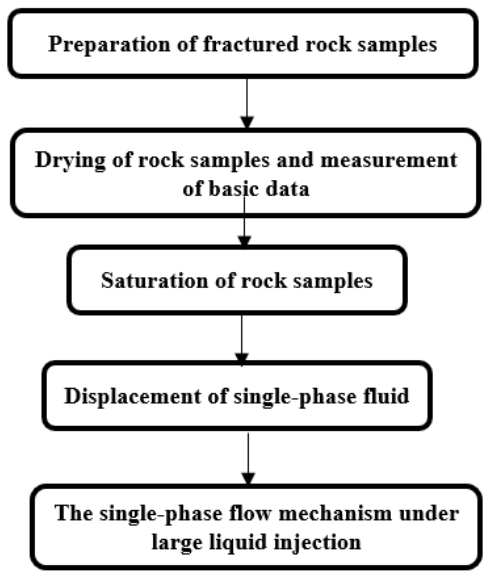
Figure 2. The operation procedure.